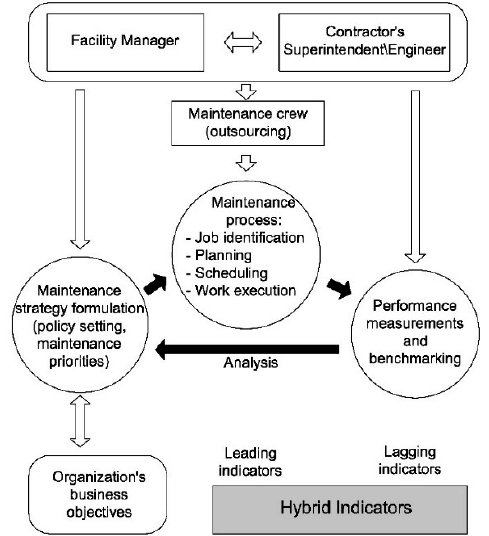
Fig. 1. Adaptation of the performance measurement framework proposed by Muchiri et al. (2011) for maintenance outsourcing in the public